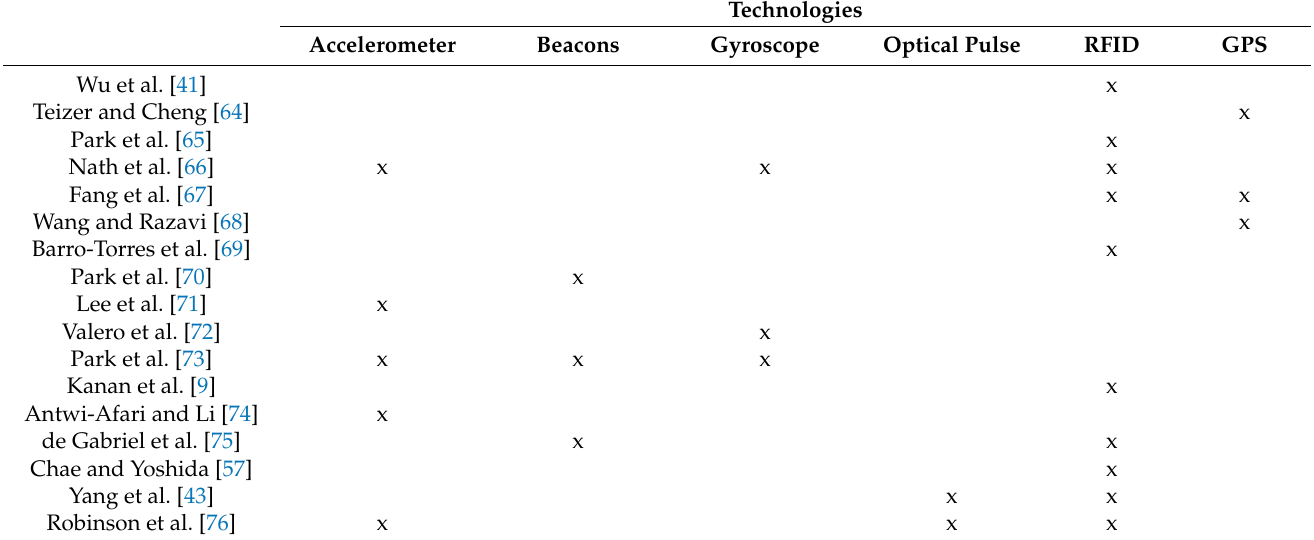
Table 1. Proposals according to technologies and project life cycle